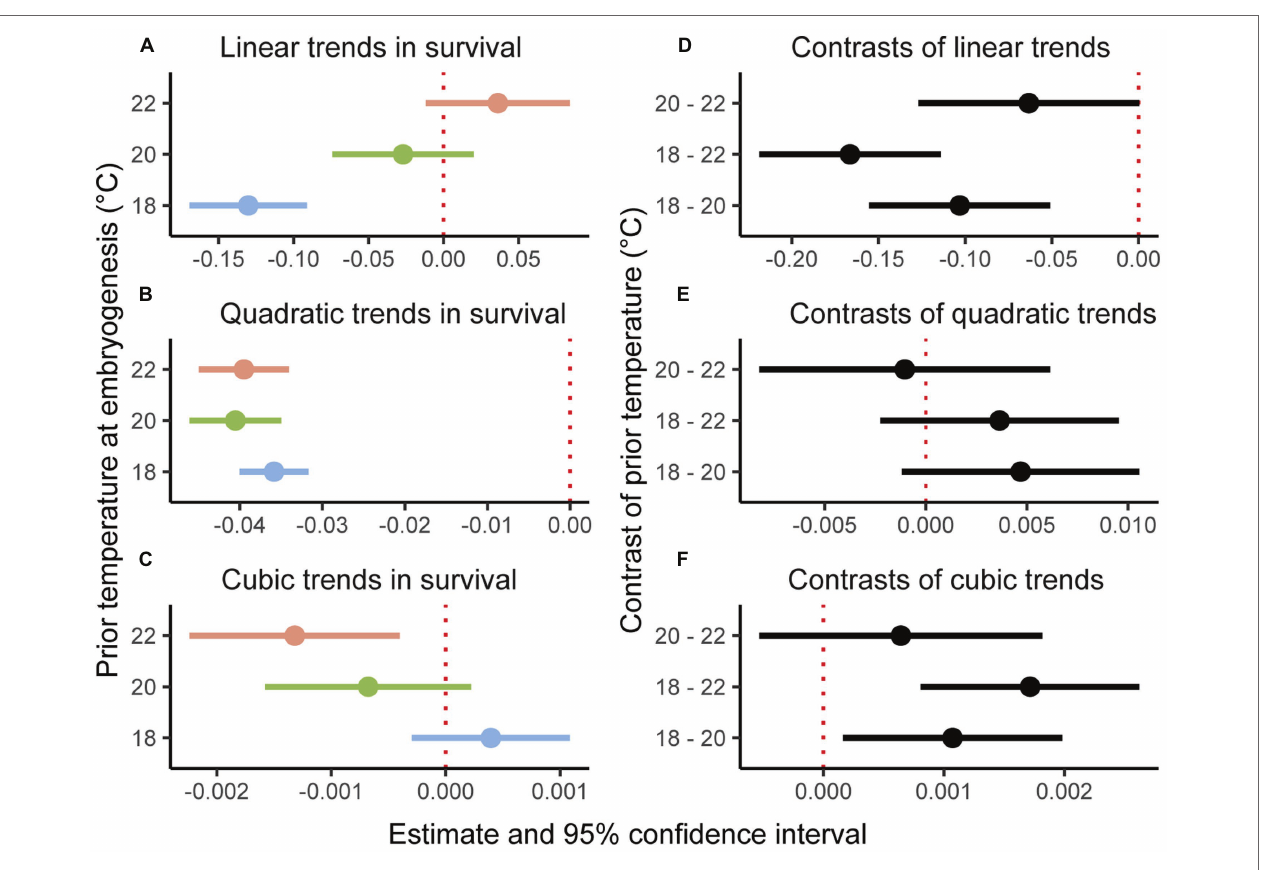
FIGURE 2 | Linear, quadratic, and cubic trends (A–C) of thermal performance curves in Figure 1 contrasted (D–F) between prior temperatures at embryogenesis. Trends and contrasts differ significantly from 0 if their estimates have 95% credible intervals that exclude zero, marked by red dotted lines.